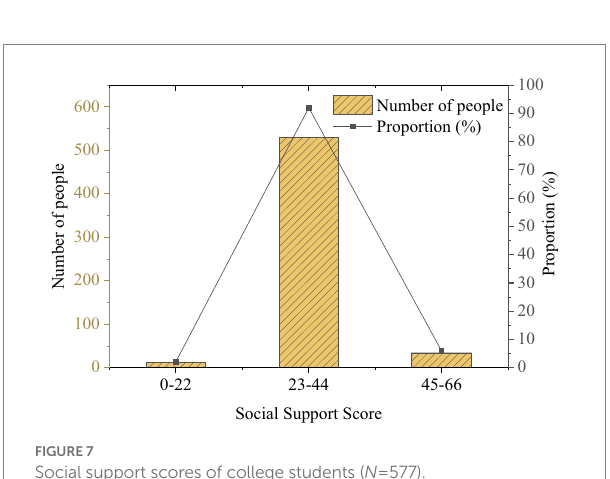
FIGURE 7 Social support scores of college students ( N = 577).